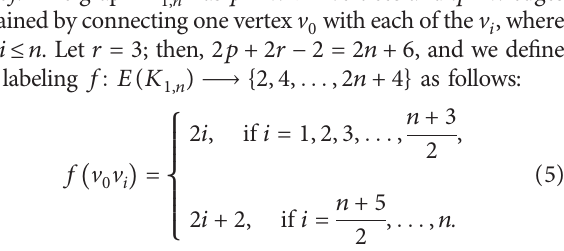
n with ordinary labeling when